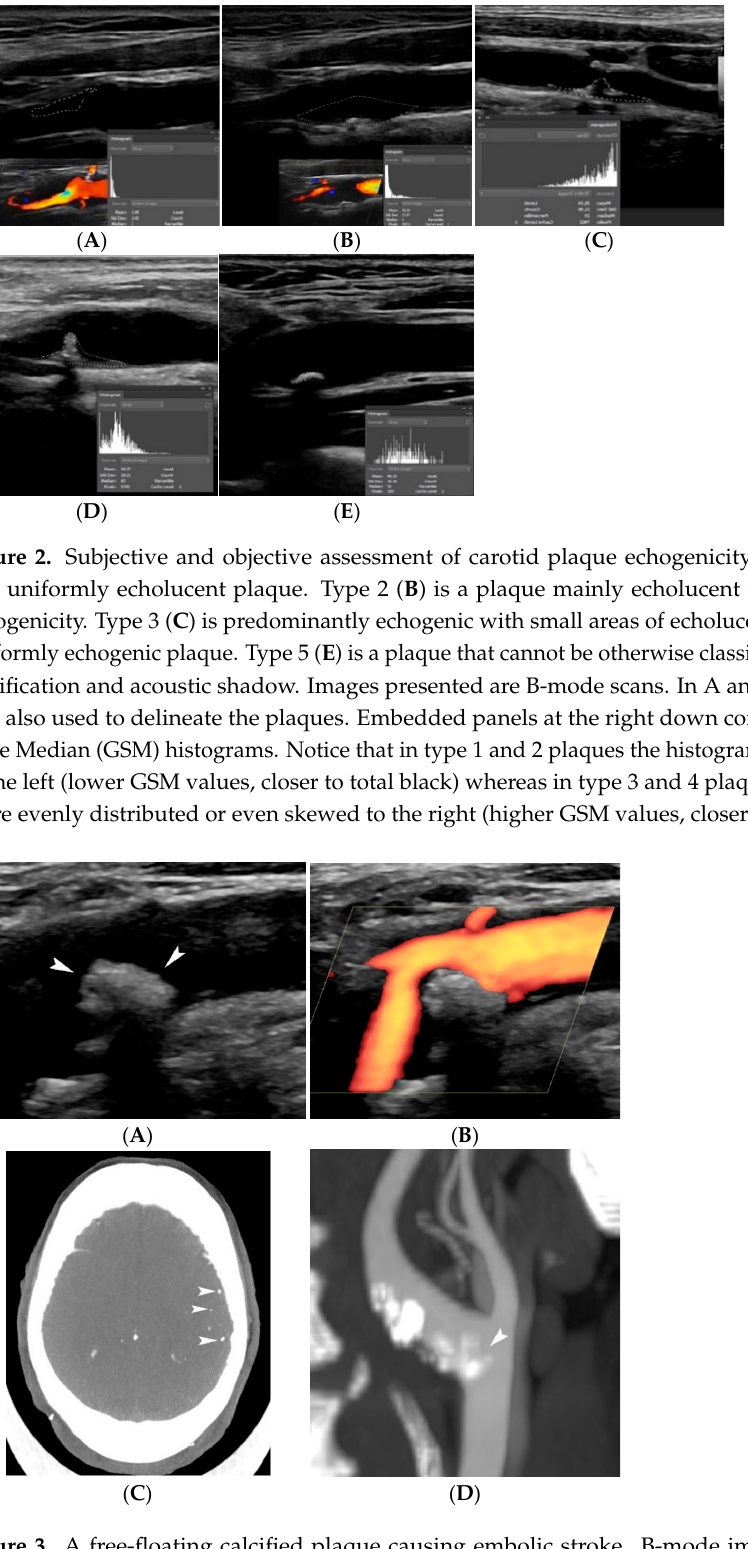
Figure 3. A free-floating calcified plaque causing embolic stroke. B-mode image ( A ) showing a free-floating intraluminal calcified plaque in the origin of the internal carotid plaque (arrowheads). Power Doppler technique ( B ) showing the moderate stenosis caused. Brain Computed Tomography ( C ) performed in the setting of multiple acute left-sided strokes showing multiple calcific emboli (arrowheads) not seen in previous scans. Computed Tomographic Angiography ( D ) confirming the intraluminally projecting calcified plaque (arrowhead) at the origin of the internal carotid